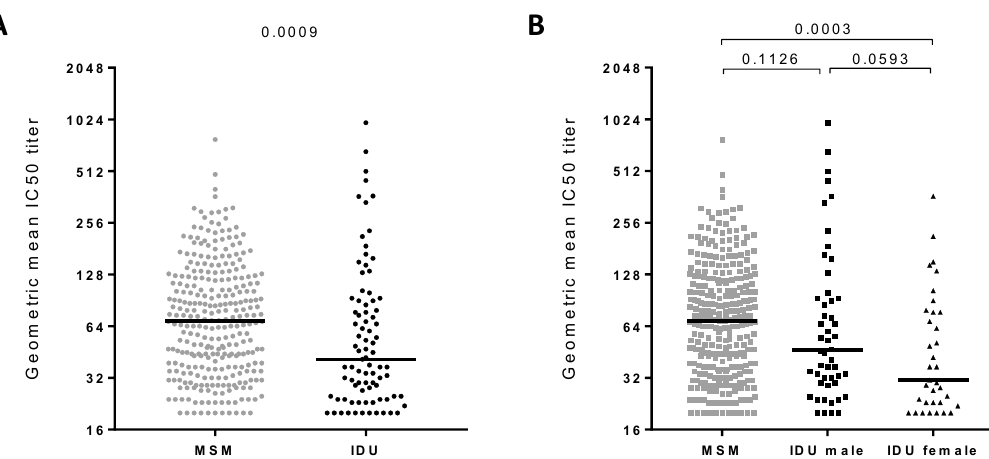
Figure 1. The potency of broadly neutralizing antibodies (bNAb) in the HIV-1 infected men who have sex with men (MSM) and injecting drug user (IDU) participants of the Amsterdam Cohort. Serum samples from MSM ( n = 299) and IDUs ( n = 85) from the Amsterdam Cohort Studies on HIV-1 infection and AIDS (ACS) were screened for the capability to neutralize six viruses from different HIV-1. ( A ) Comparison of bNAb responses in MSM (gray data points) and IDUs (black data points). Each data point represents one individual’s geometric mean ID50 titer (GMT) across the six-virus panel. ( B ) Same as A, but with the IDU separated in men (square) and women (triangle). Each data point represents one individual’s GMT. Statistically significant differences between the different cohorts were determined using a Mann–Whitney t-test and the respective P-values are shown. Horizontal bars represent the median values per group.